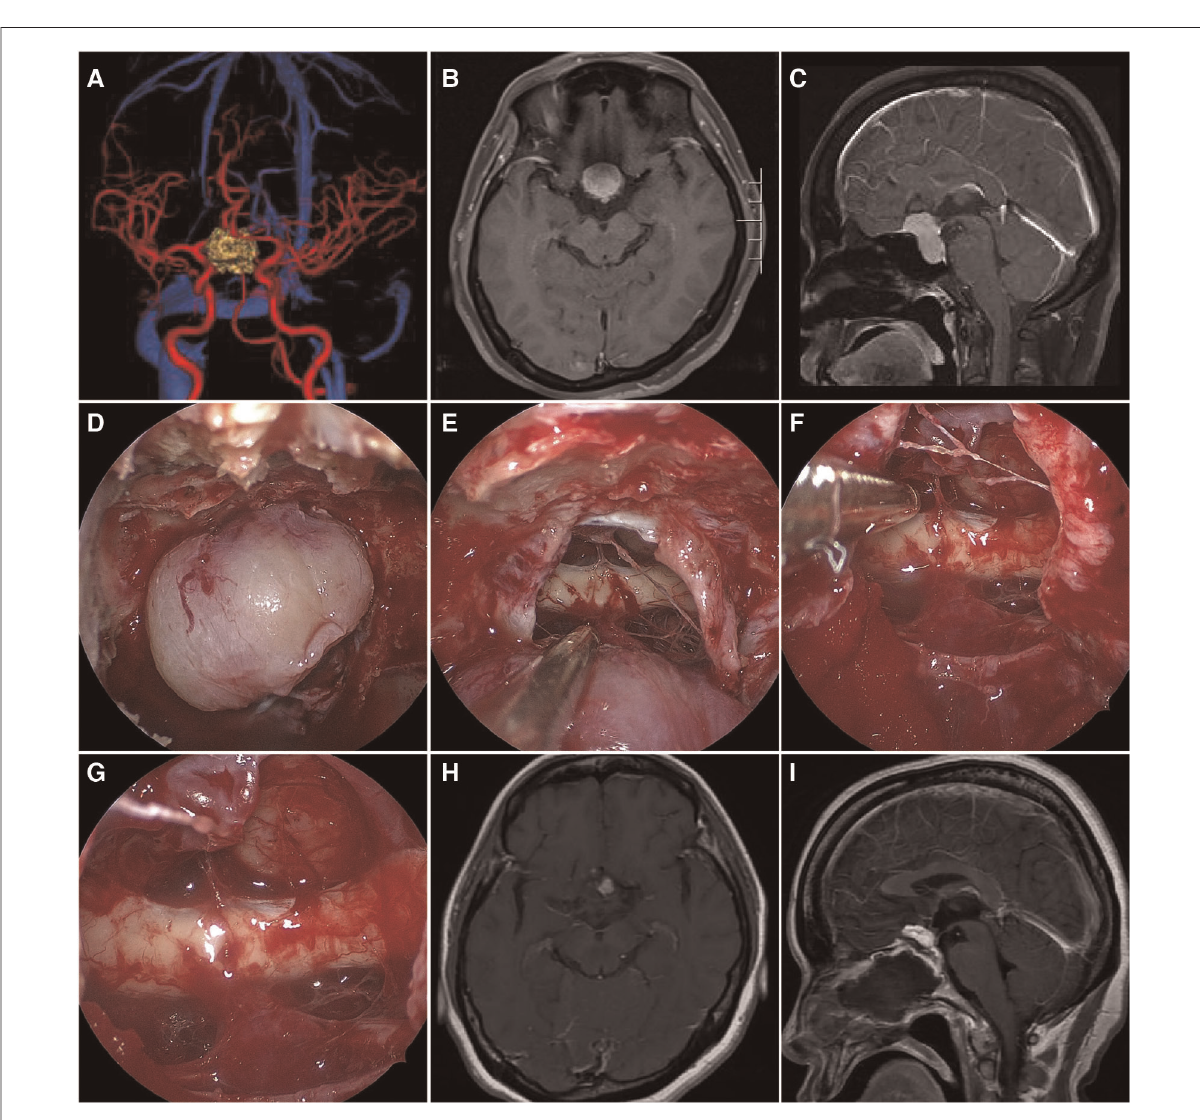
FIGURE 3 The MRI and intraoperative view of a patient operated with the ETSA. ( A ) Preoperative CTA has shown the bilateral ICA and ACA were compressed by the tumor. ( B,C ) Preoperative T1-weighted MRI scan showing the giant TSM (maximal diameter=3.1 cm) growth limited in the bilateral ICA. ( D,E ) Intraoperative microscopic view showing the tumor and the optic chiasm after opening the dura. ( F,G ) The tumor was totally removed, while the bilateral optic nerve and pituitary stalk were preserved. (H,I) Postoperative T1-weighted MRI scan con fi rming tumor